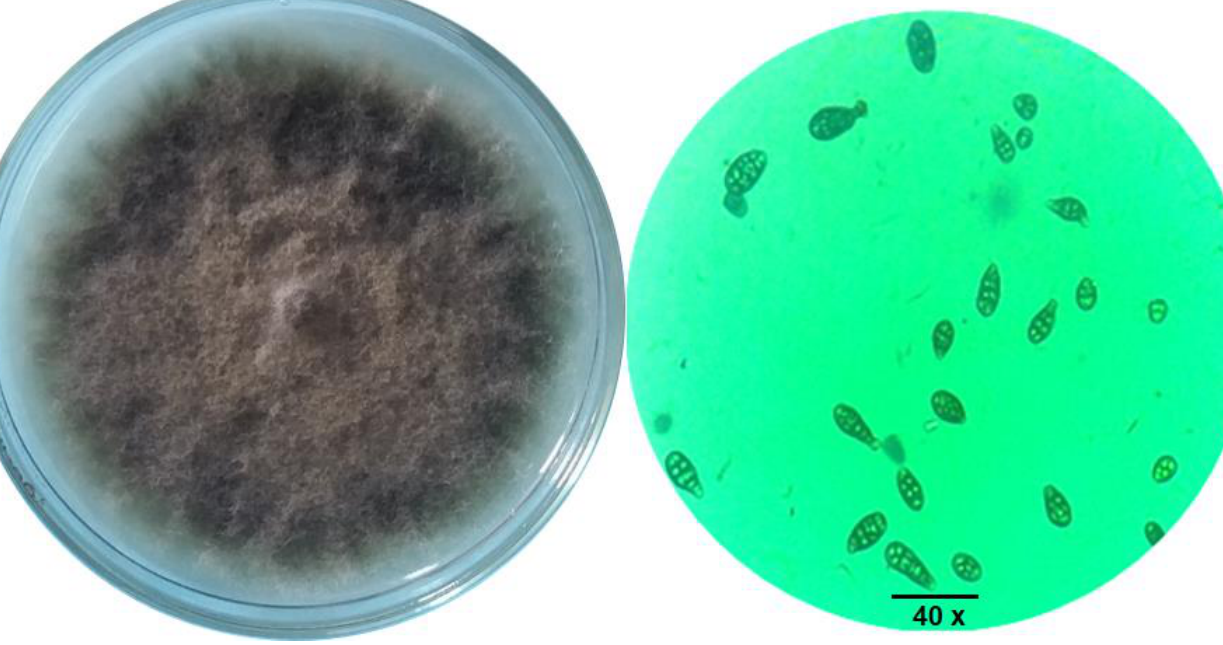
Figure 2. Artificially infection of Dosera tomato cultivar seedlings with four Alternaria spp. isolates (a spore suspension with a concentration of 3 × 10 6 spore/mL) showing early blight symptoms for 10 days after inoculation. Table 2. Origin, percent disease index and accession numbers of four isolates of Alternaria solani used in this study.